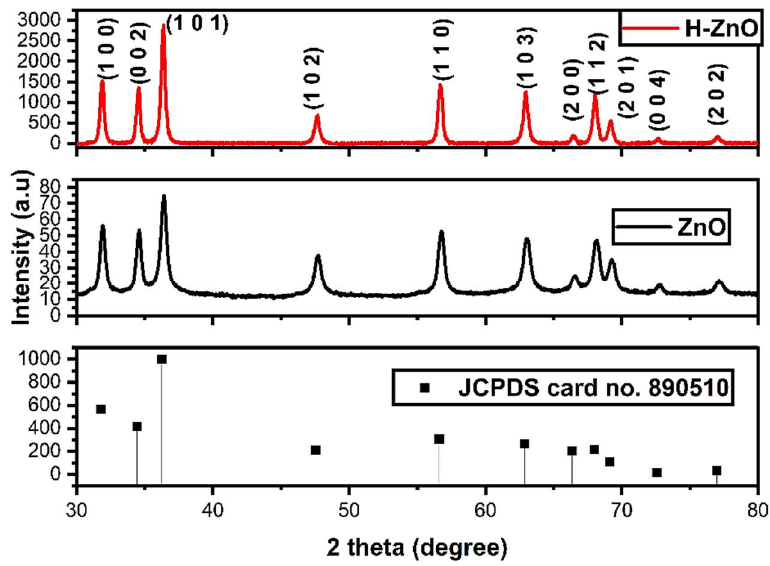
Figure 1. XRD patterns of bare ZnO and honey-capped ZnO nanoparticles.